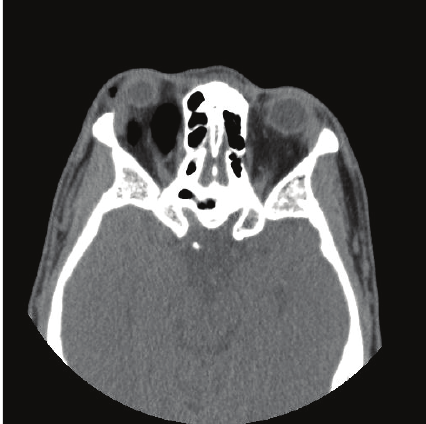
Figure 2: Diffuse intraconal/preseptal air and severe proptosis of the right eye resulting in tenting of the optic globe and stretching of the optic nerve.